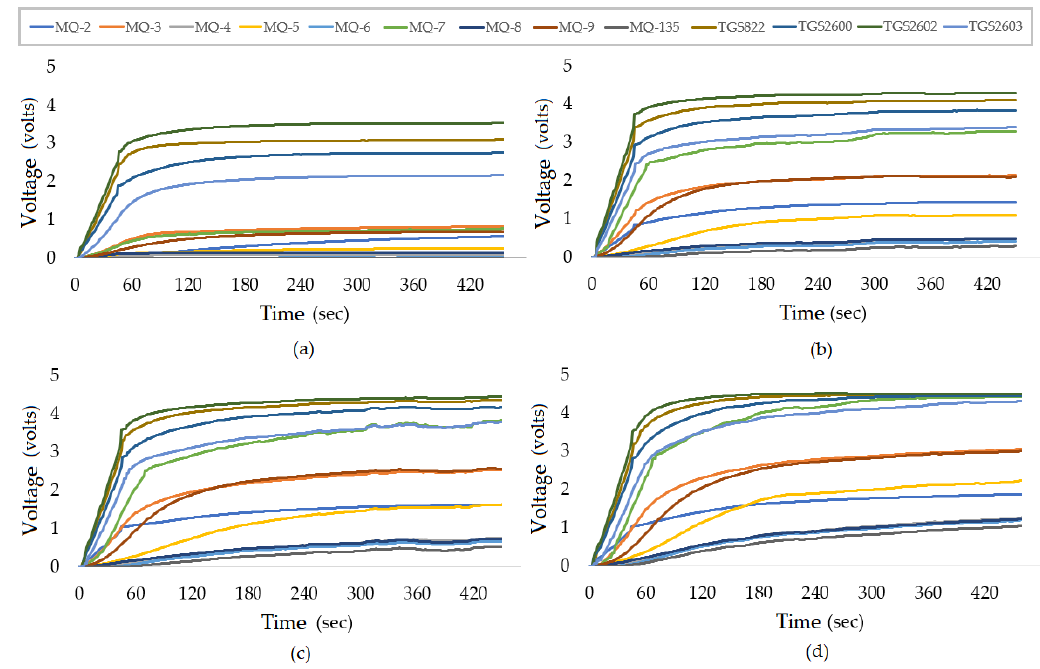
Figure 5. Sensor response. ( a ) for the 1% sample; ( b ) for the 3.9% sample; ( c ) for the 6% sample; ( d ) for the 8% sample.